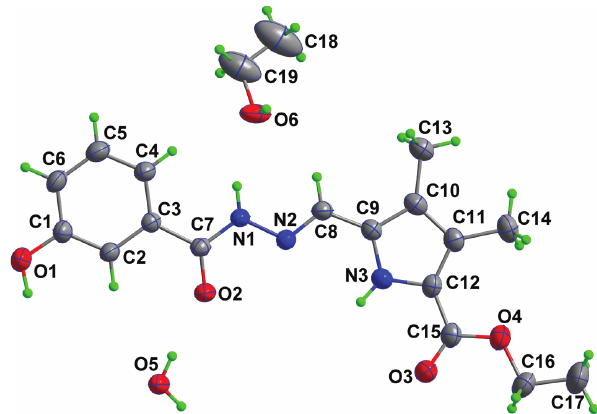
Table 2: Fractional atomic coordinates and isotropic or equivalent isotropic displacement parameters (Å 2